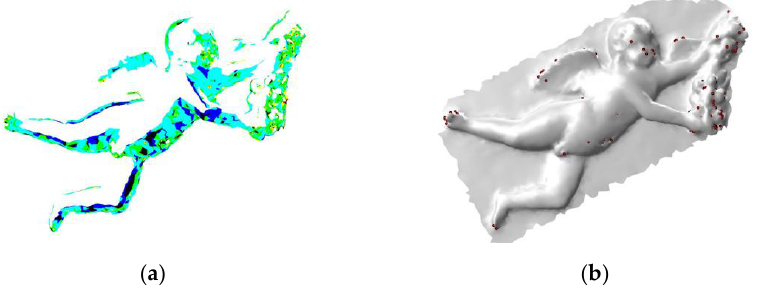
Figure 3. The same input models as in Figure 2 rendered and texturized by the color map in accord- ance with the computed features, respectively: ( a ) Gaussian curvature, ( b ) mean curvature, ( c ) gra- dient of the Gaussian curvature, ( d ) maximal dihedral angle, and ( e ) theta angle. In the used color map, blue corresponds to low values and red to high values of the computed feature.